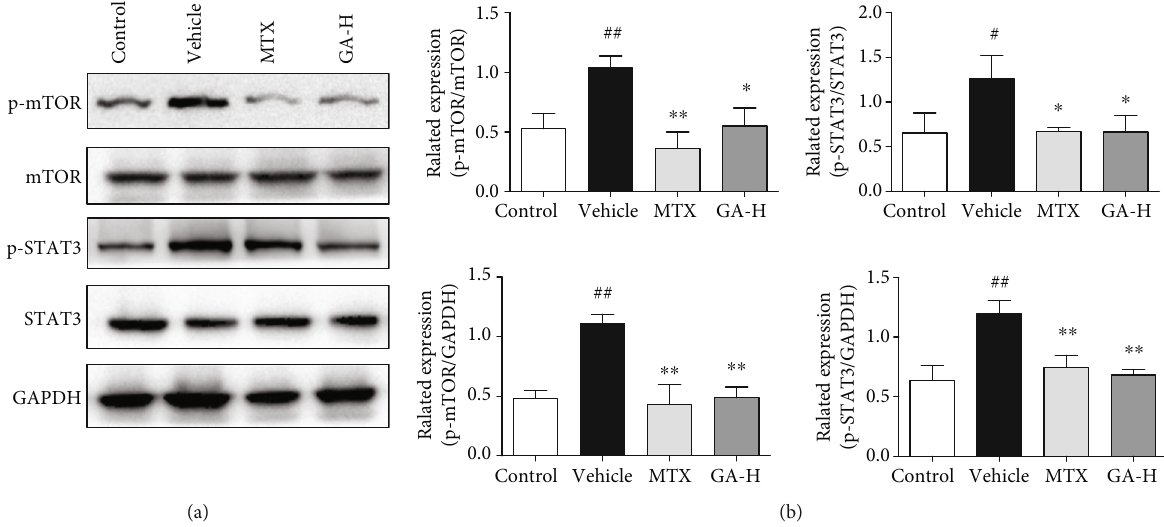
Figure 6: GA inhibits p-mTOR and p-STAT3 protein expression in the skin of IMQ-induced psoriasis-like mice. Impacts of GA on the protein expression of p-mTOR and p-STAT3 in skin tissue of IMQ-induced psoriasis-like mice were determined using Western blotting after GA treatment. The expression of p-mTOR, mTOR, p-STAT3, and STAT3 was detected using Western blotting (a). The densitometry analyses of the immunoblotting are shown as p-mTOR/mTOR, p-mTOR/GAPDH, p-STAT3/STAT3, and p-STAT3/GAPDH (b). Data shown are the means ± SD ( n = 3 , # P < 0 : 05 and ## P < 0 : 01 vs. control group, ∗ P < 0 : 05 and ∗∗ P < 0 : 01 vs. vehicle